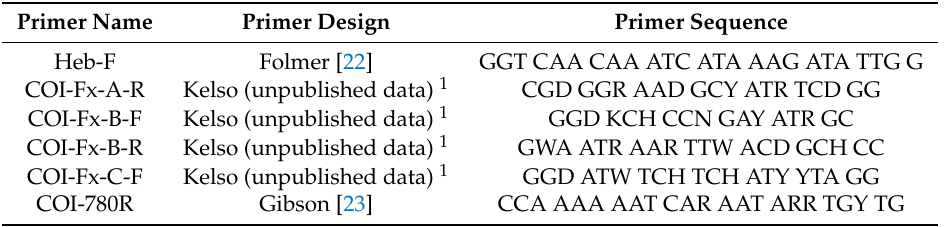
Table 1. Custom primers used in the DNA analysis of Meromacrus adults (Diptera: Syrphidae).